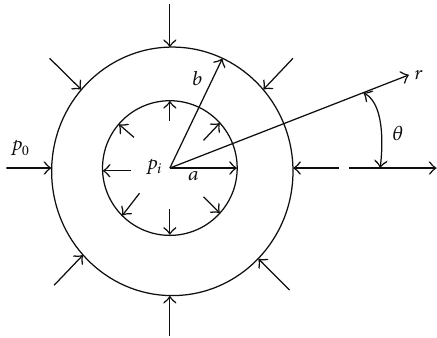
Figure 1: A functionally graded rotating cylinder with inner pressure 𝑝 𝑖 and outer pressure 𝑝 0 at the